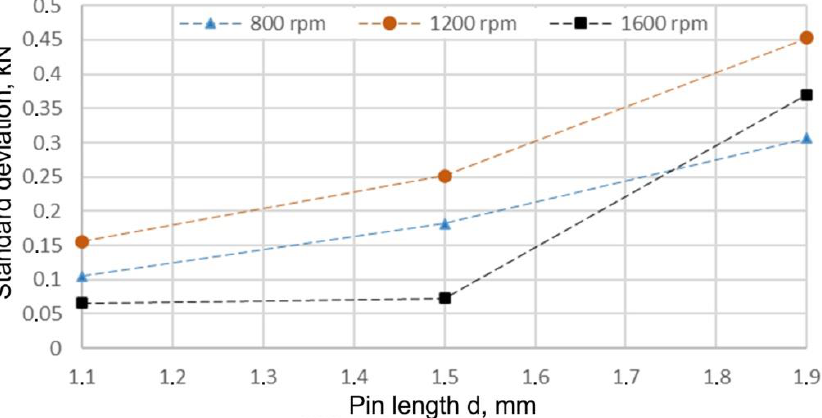
Figure 16. Standard deviation of the test results for a welding speed of x 2 = 200 mm/min.